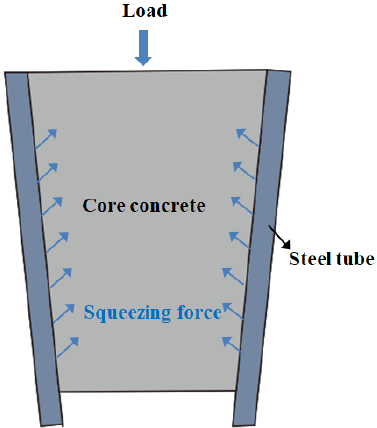
Figure 12. Pinching effect diagram.